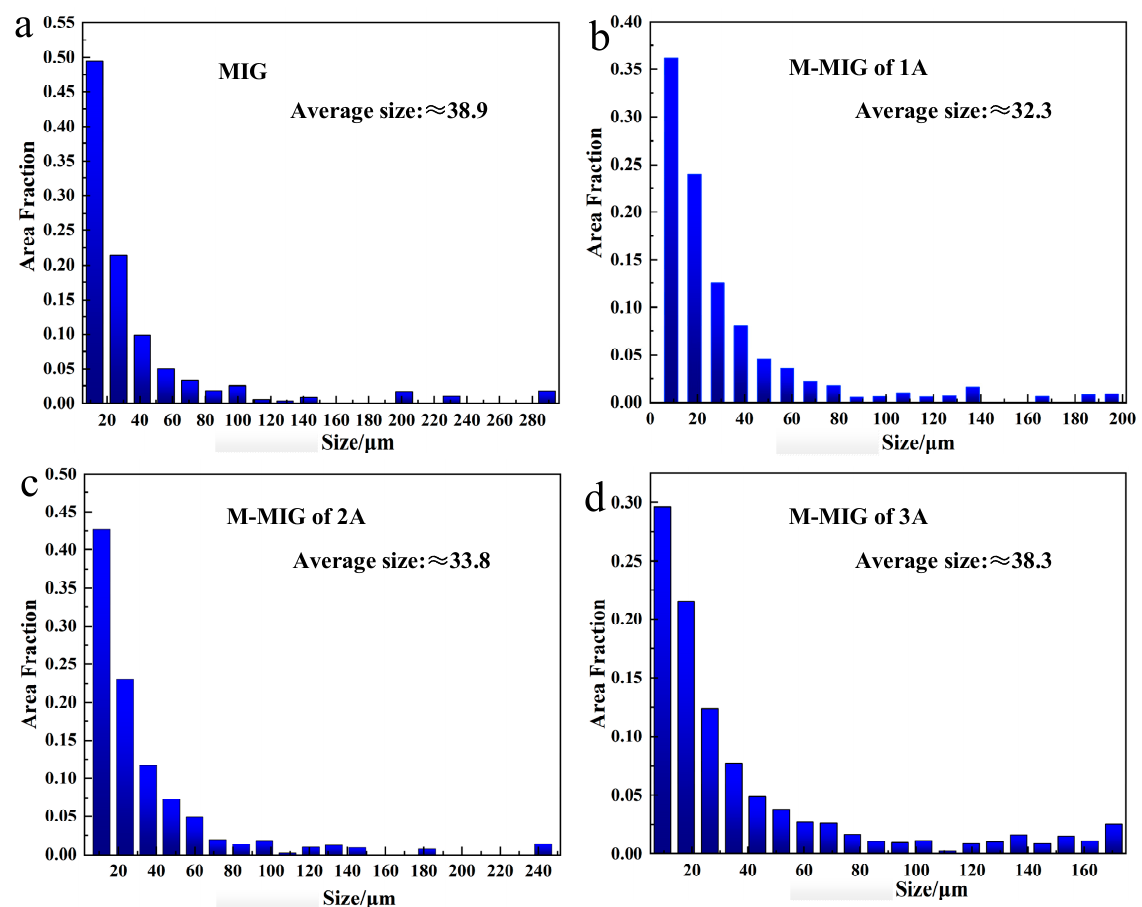
Figure 8. The size of α and β phase in the titanium alloy DED-AAM component with the wire feeding speed of 7 m/min: ( a ) I M = 0 A, ( b ) I M = 1 A, ( c ) I M = 2 A, ( d ) I M = 3 A.